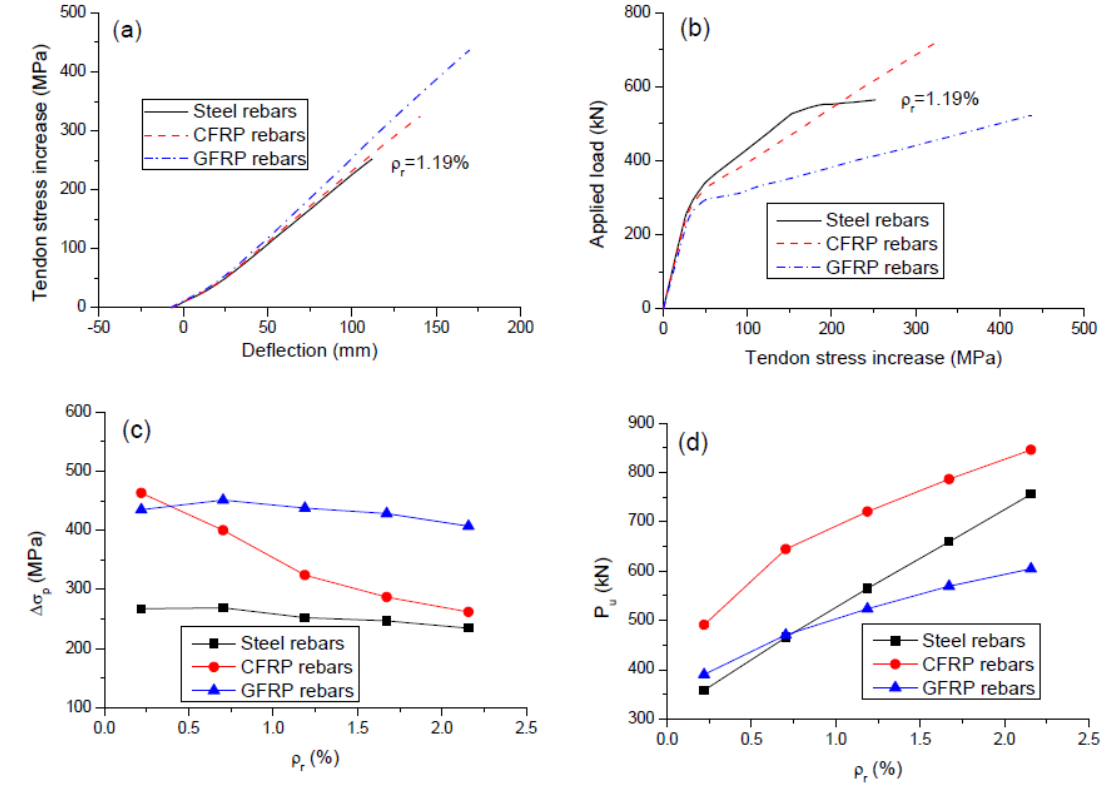
Figure 7. Tendon stress development for the beams with different types of rebars. ( a ) midspan deflection versus tendon stress increment; ( b ) load versus tendon stress increase; ( c ) variation of ultimate tendon stress increment with varying ρ r ; ( d ) variation of ultimate load with varying ρ r.